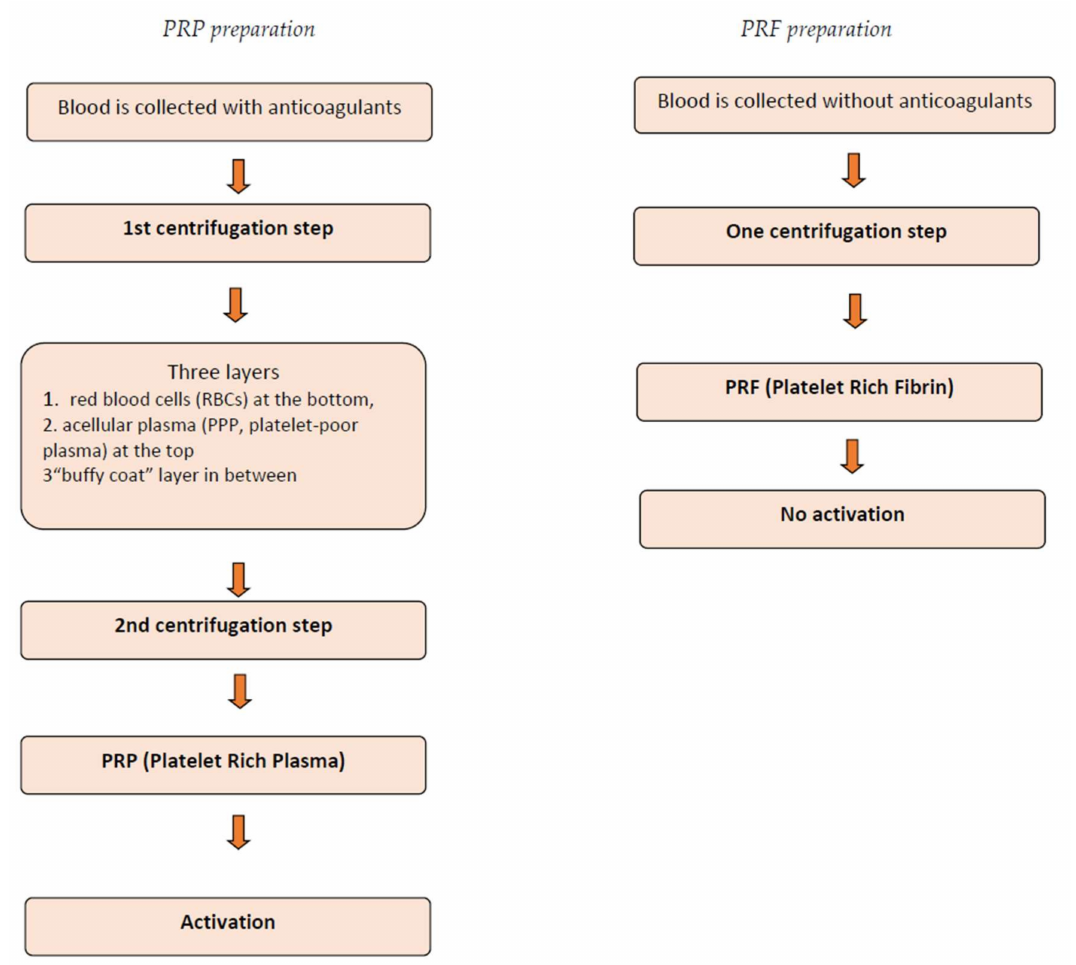
Figure 1. Main phases of platelet rich plasma (PRP) and platelet rich fibrin (PRF)